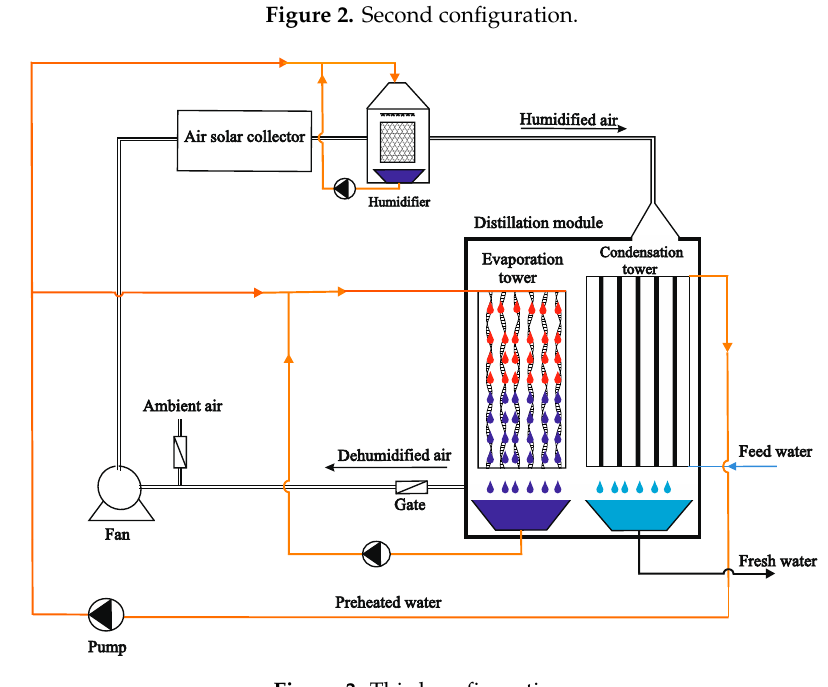
Figure 3. Third configuration. Figure 3. Third